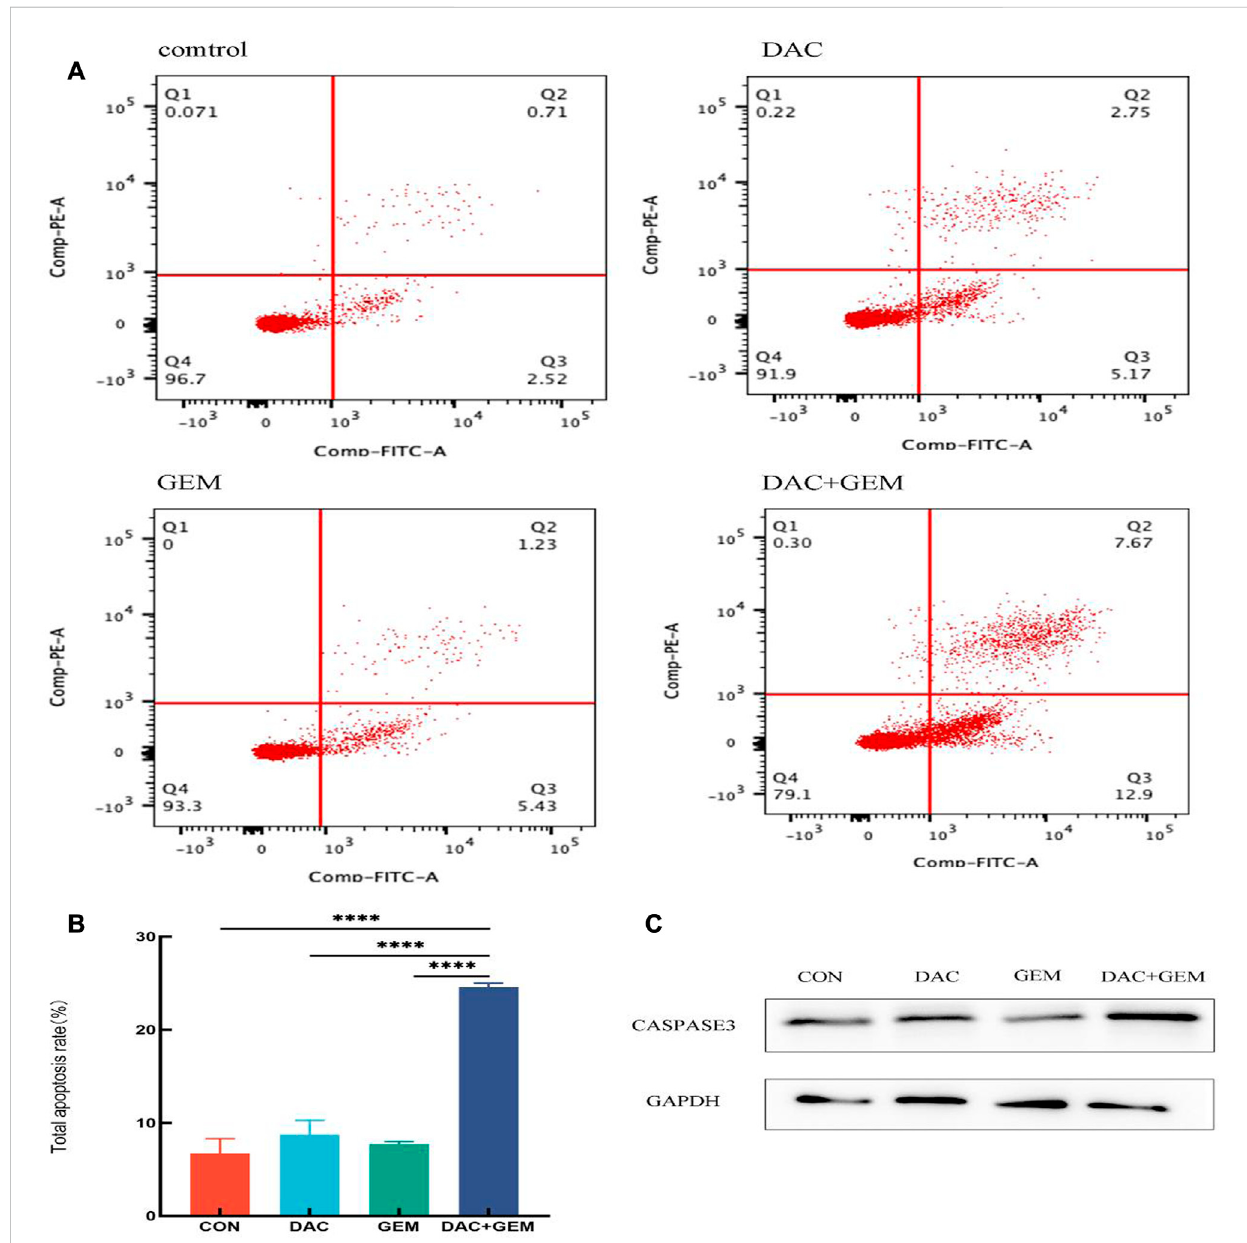
FIGURE 2 The combination of DAC with 4.046 µM and GEM with 0.005 µM signi fi cantly promotes apoptosis in NK92MI cells. (A, B) Cell apoptosis assay in NK92MIcellstreatedwiththeindicateddoseofDACandGEMaloneorincombination. (C) AftertreatingwiththeindicateddoseofDACandGEMaloneor in combination, Caspase-3 protein expression was immunoblotted in NK92MI cells. * p < 0.05, ** p < 0.01, *** p < 0.001 versus control group and alone